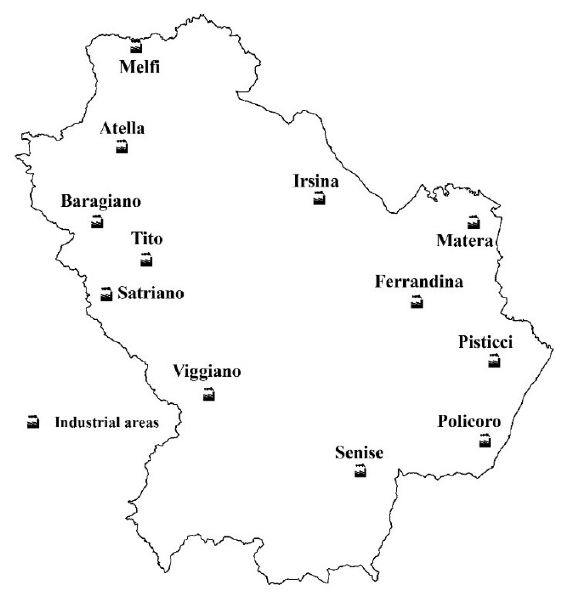
Figure 4. Identification of used processing